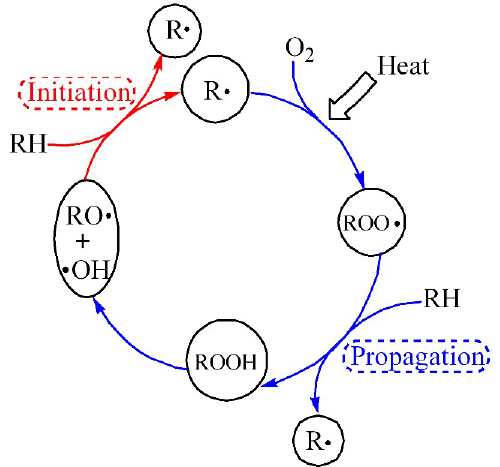
Figure 4. Initiation and propagation of thermal oxidation of PE chains under heat and O 2 .